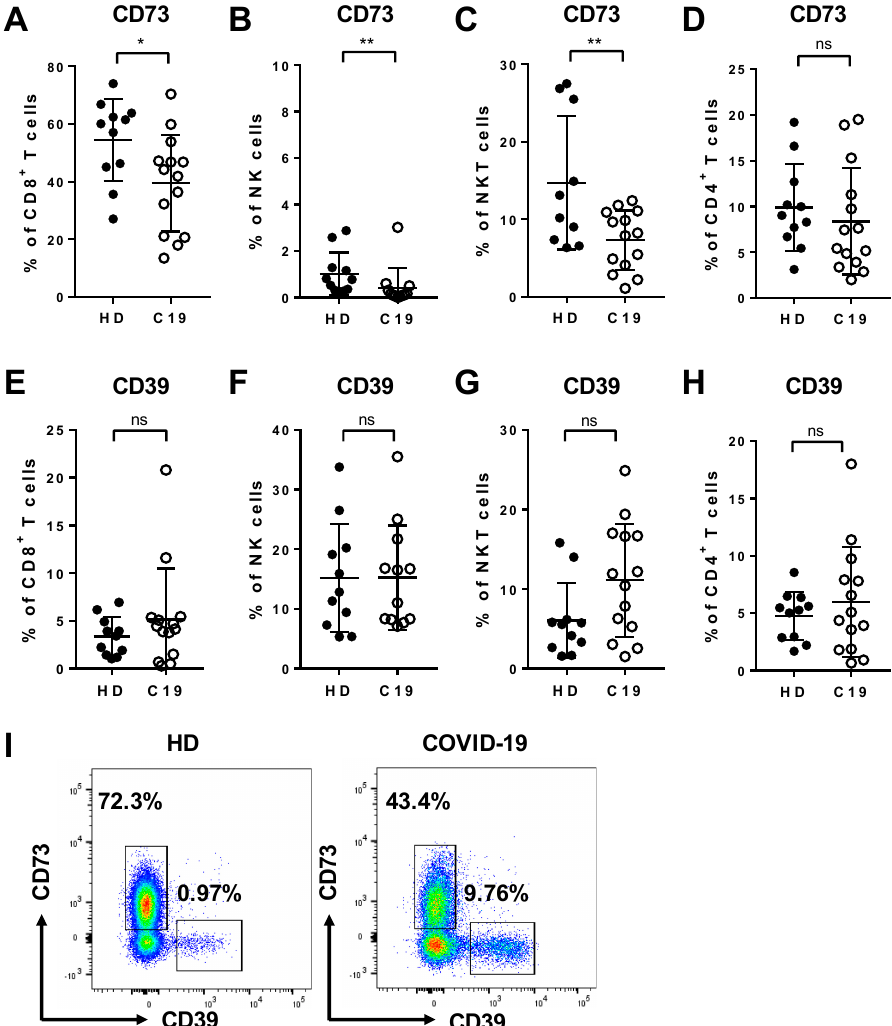
Figure 2. Expression of CD73 and CD39 on different leukocyte populations in COVID-19. PBMCs from COVID-19 patients (C19) and healthy donors (HD) were analyzed ex vivo in unstimulated cells by flow cytometer. In COVID-19 patients, there was a significant decrease in the frequency of CD73 - expressing CD8 + T cells ( A ), NK cells ( B ), and NKT cells ( C ). In contrast, the frequency of cells expressing CD39 was elevated among CD8 + T cells ( E ), NK cells ( F ), and NKT cells ( G ) without reaching statistical significance. The expression of both CD73 and CD39 was unaltered on CD4 + T cells